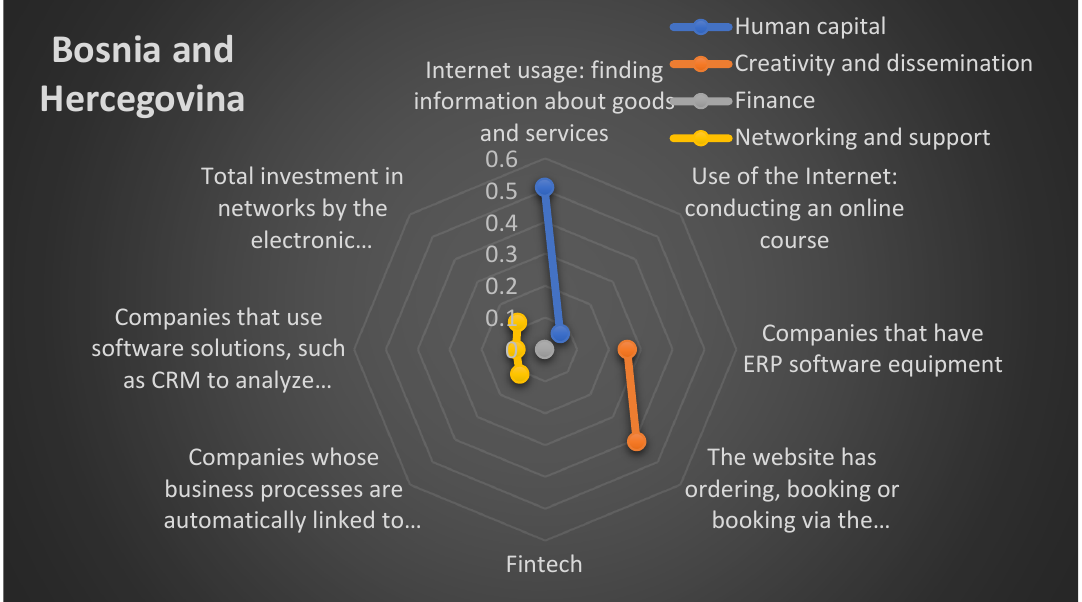
Figure 4. Values of the factors of the digital entrepreneurial system of Bosnia and Herzegovina, in the scale-up phase of the life cycle of the enterprise, in the digital dimension.